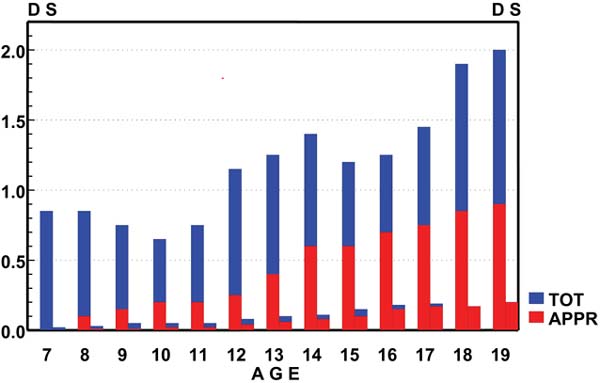
Caries incidence 1979 and 1999. County of Värmland